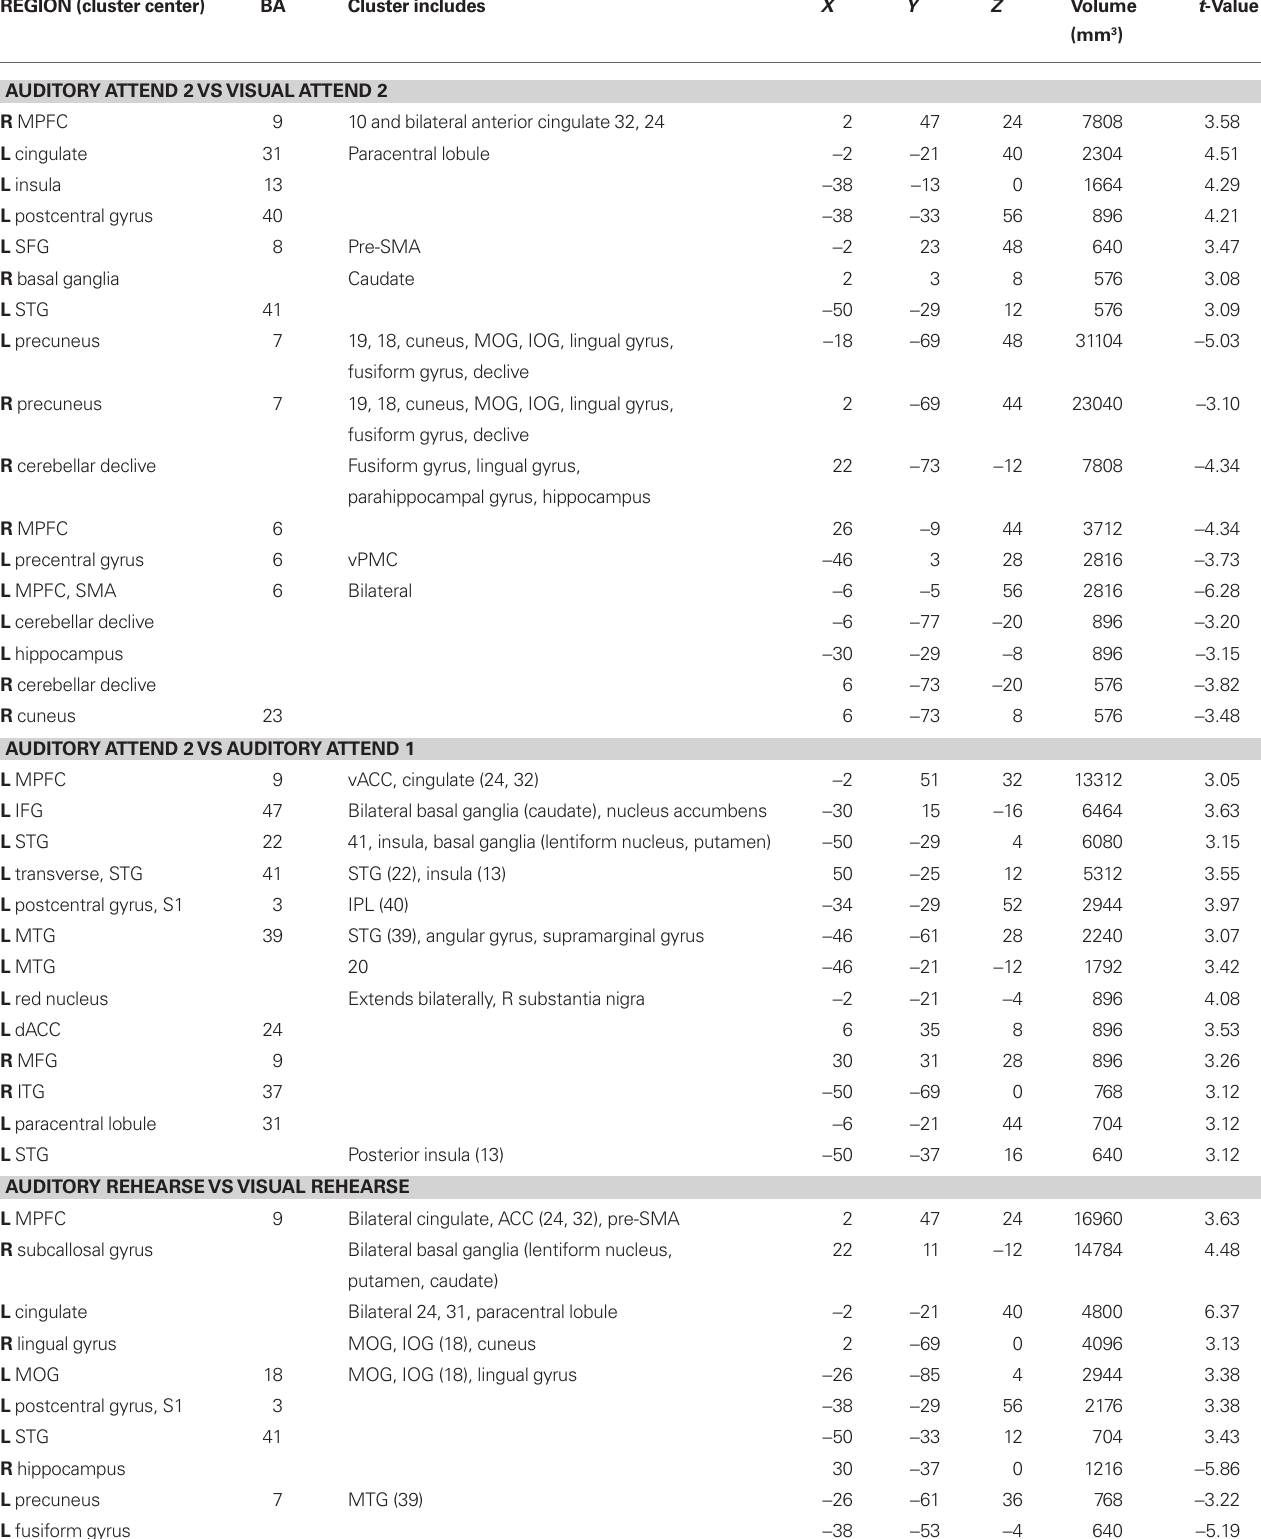
Table 3 | Between auditory and visual condition activations ( p < 0.002 corrected). RegIOn (cluster